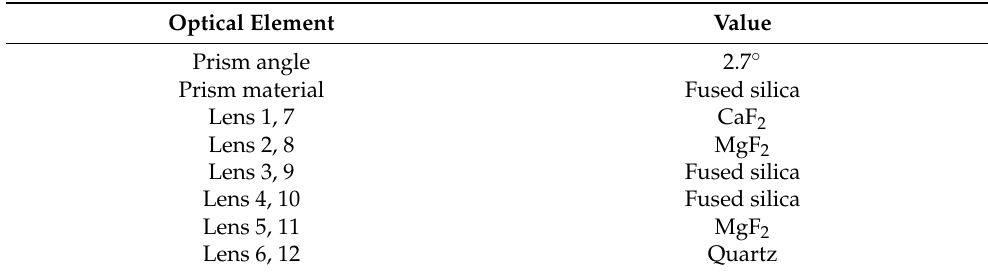
Table 3. List of spectrometers optical elements materials.